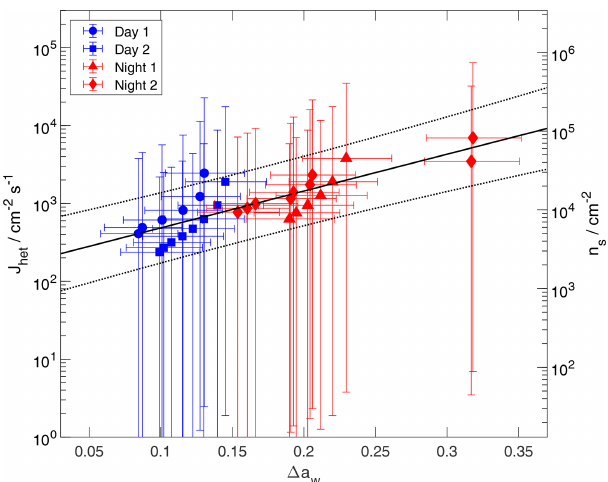
Figure 9. Kinetic DIN data of examined ACE-ENA particle sam- ples (solid symbols). Heterogeneous ice nucleation rate coefficients ( J het ) and INAS density ( n s ) are presented. Error bars included un- certainties in temperature, humidity, and surface area. Solid and dot- ted black lines represent a linear regression fit and associated fit un-